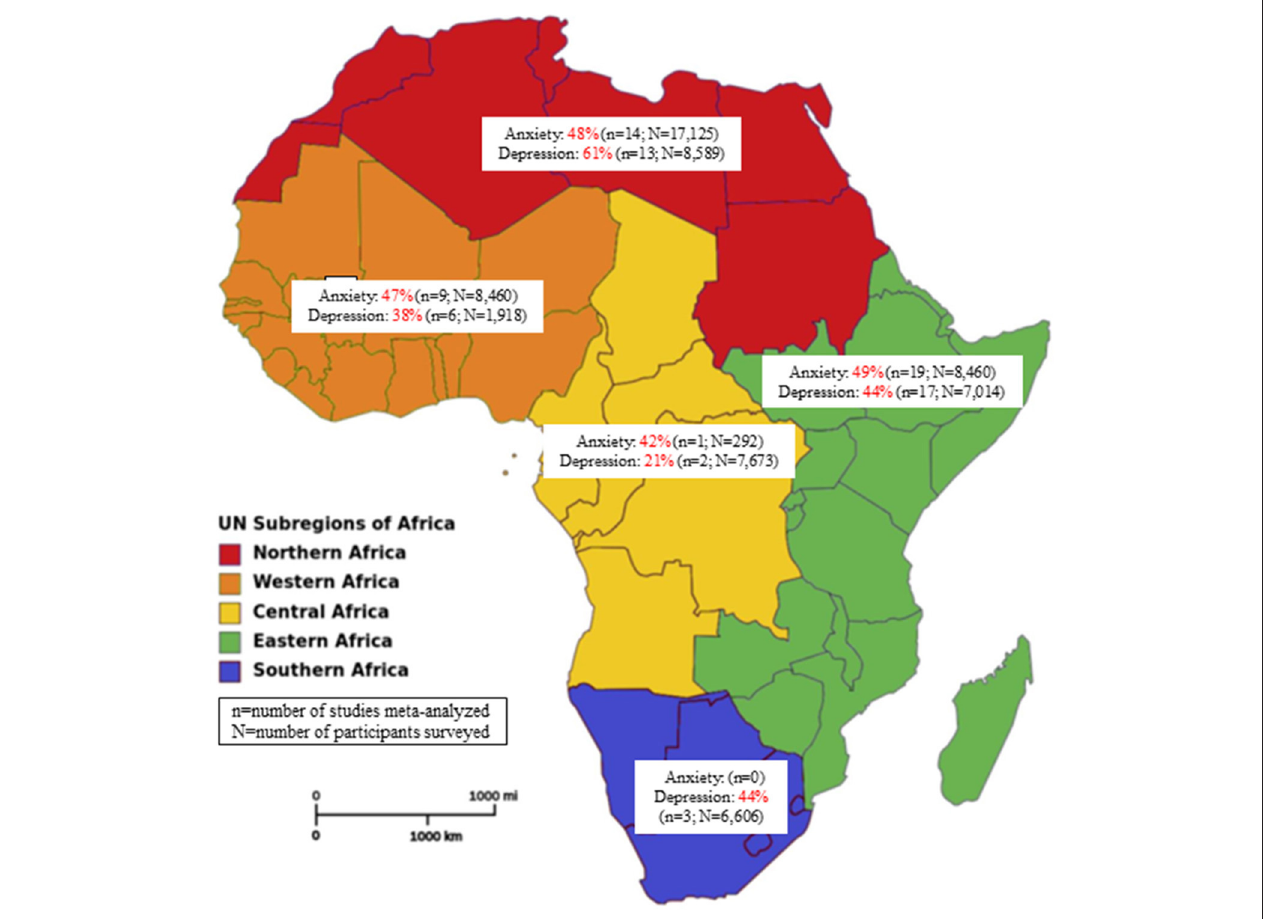
FIGURE 3 | Prevalence of anxiety and depression in Africa by regions during the COVID-19 pandemic (source of image: File:Africa map regions 2.png-Wikipedia).